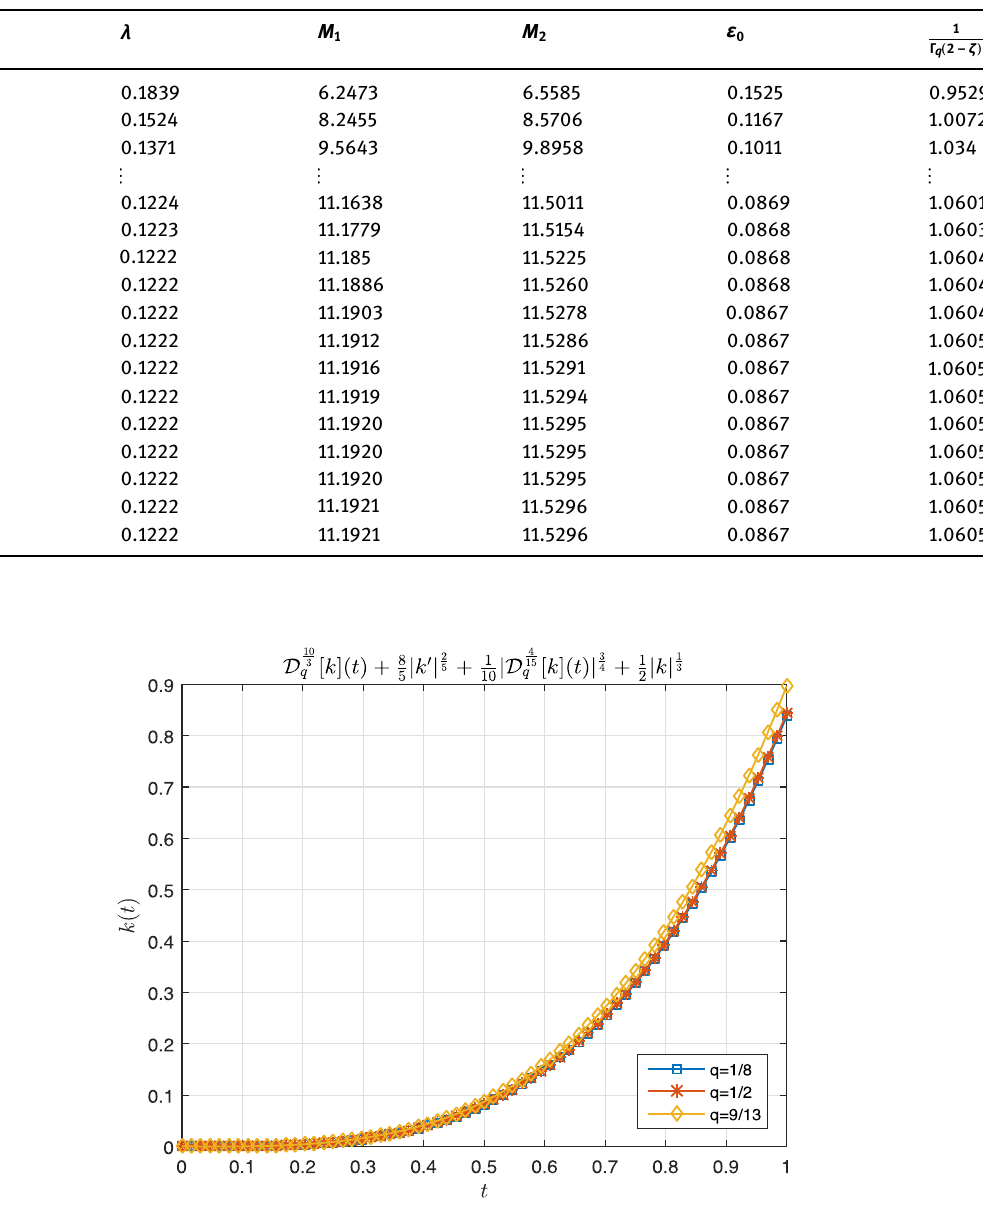
Figure 2: ( ) k t with respect to t for Equations in ( 27 ) in Example 4.2 for { } ∈ q , , 1